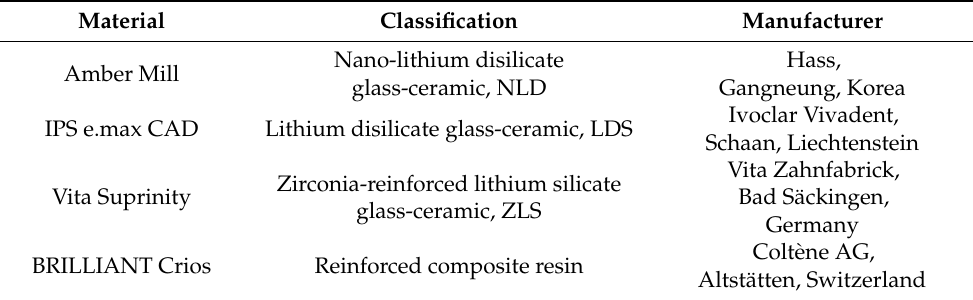
Table 1. List of CAD-CAM materials used in this